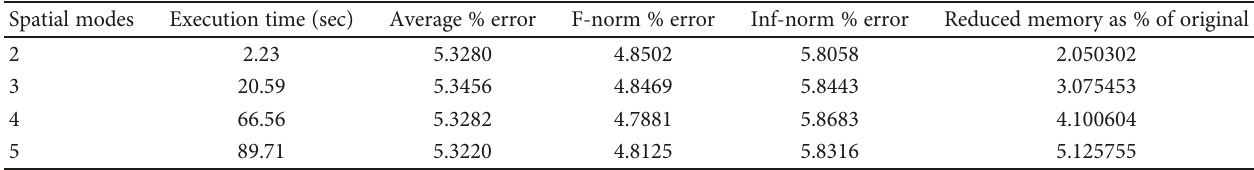
Table 11: Density in an y × z plane with i = 150 .